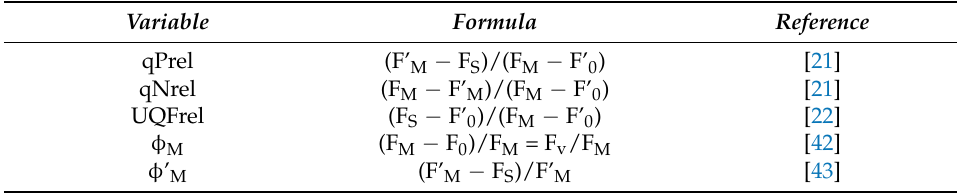
Table 2. List of Chl a fluorescence variables with their respective